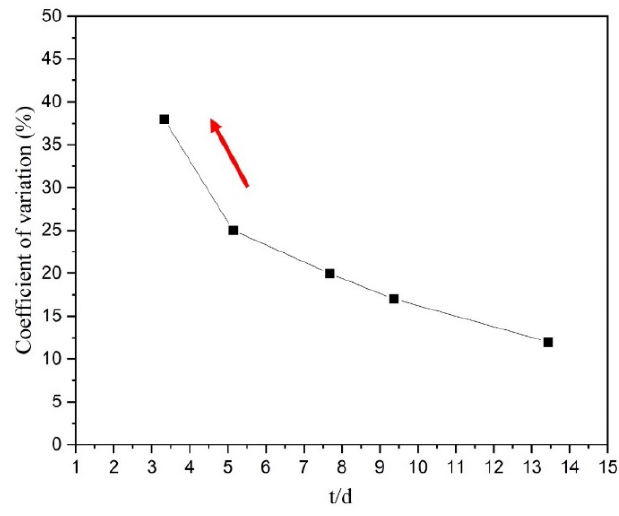
Figure 4. The change in C.V ( δ ) with the t/d value.